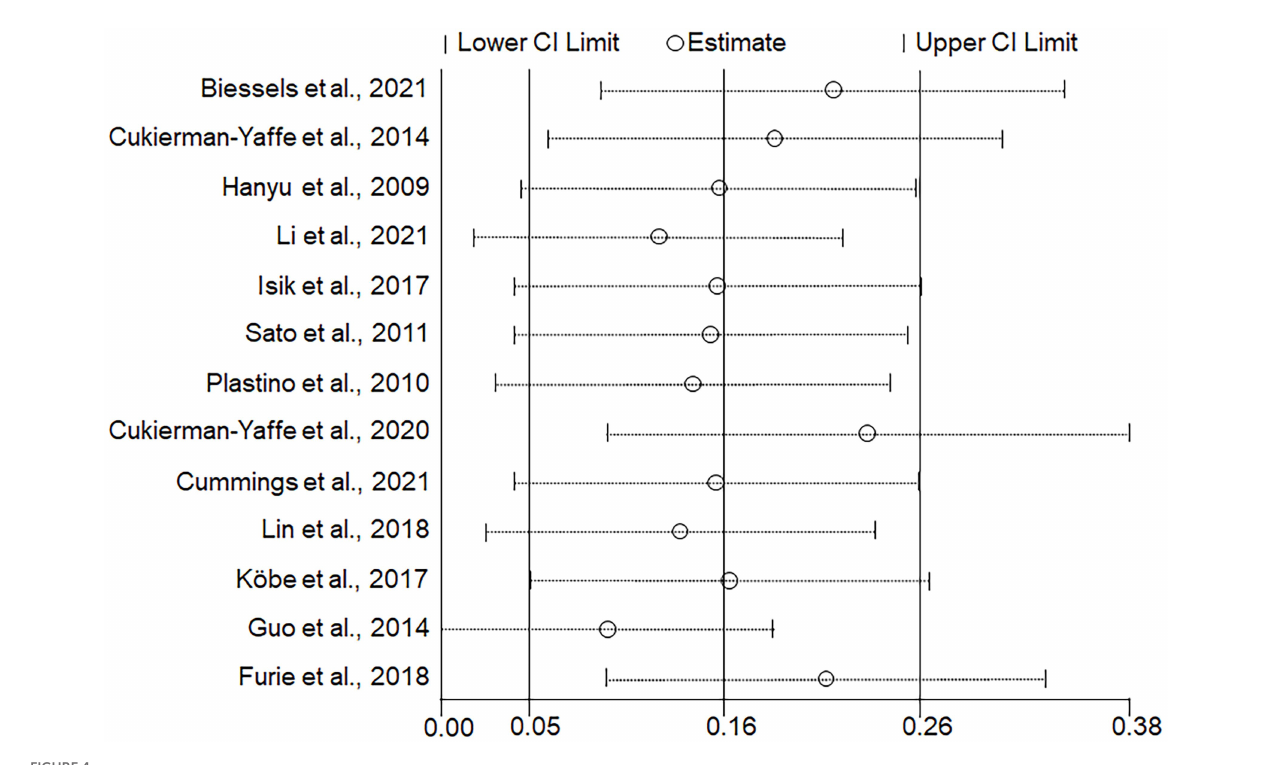
FIGURE 4 Sensitivity analysis for included